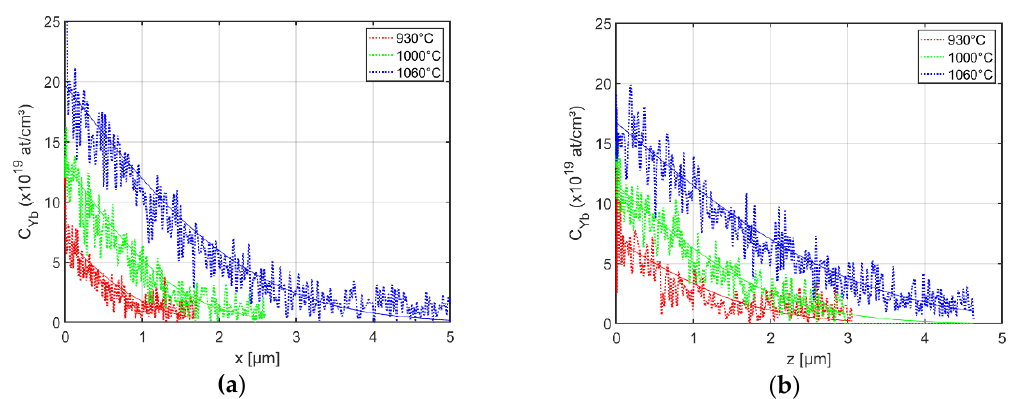
Figure 3. SNMS depth profiles of Yb in LiNbO 3 for in-diffused layers with an initial thickness of 20 nm annealed for 30h at different temperatures for (a) x-cut and (b) z-cut substrates. The dotted lines show the measured profiles and the solid lines indicate complementary error function fits.